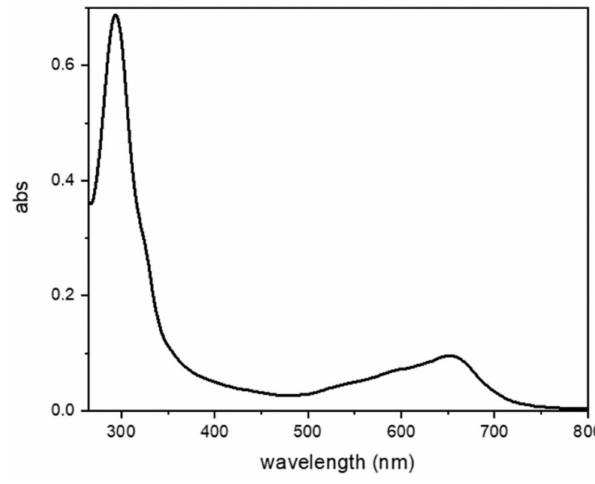
Figure 8. Absorption spectrum of Bpy-SH@AuNT in water solution.